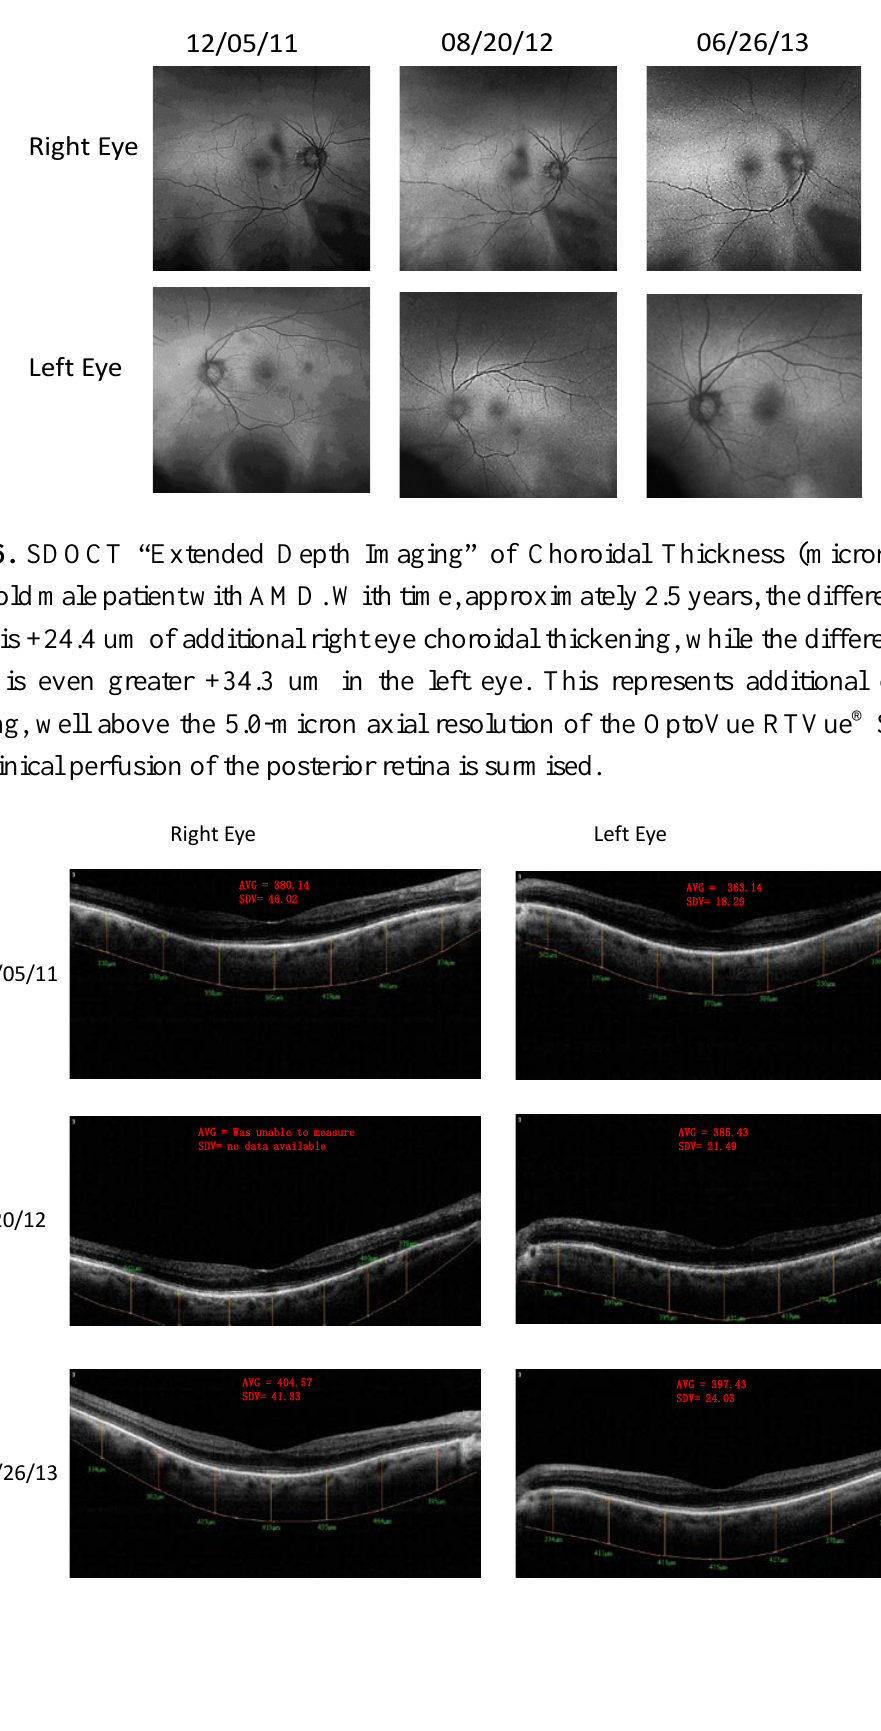
Figure 5. Wide field OPTOS FAF images of lipofuscin within the neurosensory retina of an 89-year-old male patient with AMD. Images of lipofuscin within broad geographic section of the retina is shown to diminish in intensity over time, especially within his left retina.